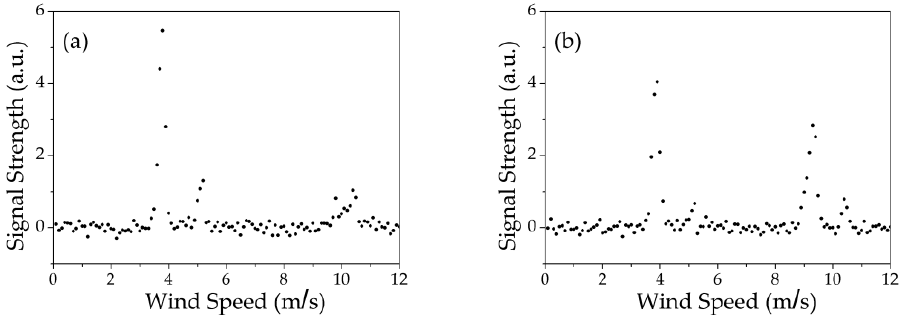
Figure 5. The spectra of radial wind measurements. ( a ) Spectrum 1; ( b ) Spectrum 2. Table 3. Key parameters of the CDWL.